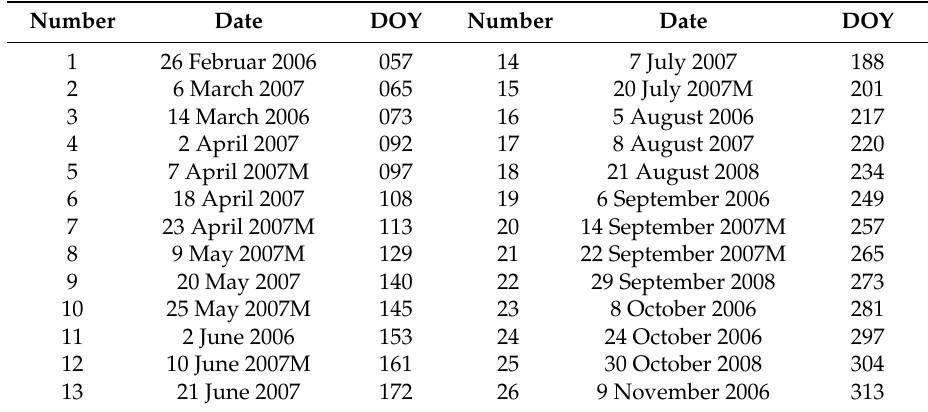
Table 1. Time series of Landsat and MODIS fused images.